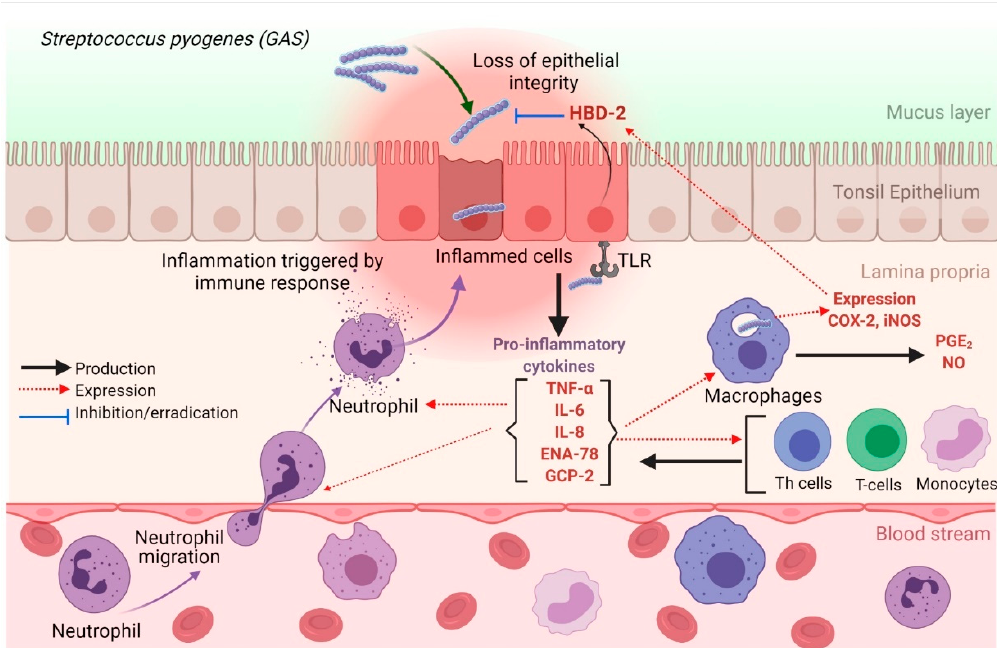
Figure 7. Possible mechanisms of releasing pro-inflammatory cytokines by tonsil epithelial cells during GAS infection. TLRs recognize GAS during the invasion, which results in the release of inflammatory cytokines by inflamed epithelial cells. The secretion of pro-inflammatory cytokines (IL-6 and IL-8) potently promotes the recruitment of neutrophils and macrophages to the site of inflammation. TNF- α activates the NF- κ B pathway, which facilitates the expression of pro-inflammatory and cell survival genes. GAS: Group A streptococcus; IL-6: interleukin-6; IL-8: interleukin-8; iNOS: inducible nitric oxide synthase; HBD-2: human beta defensin-2; GCP-2: granulocyte chemotactic protein-2; NF- κ B: nuclear factor-kappa B; ENA-78: epithelial-derived neutrophil-activating protein-78; NO: nitric oxide; TLR: Toll-like receptors, TNF- α : tumor necrotic factor-alpha. The figure was created using BioRender.com.